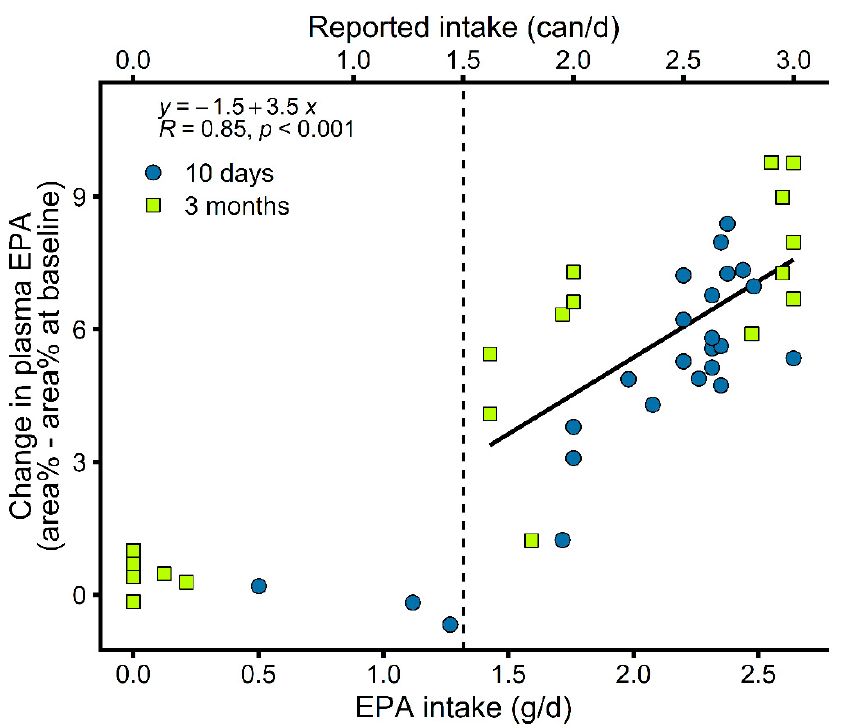
Figure 4. A Plasma EPA dose-response in breast cancer patients supplemented with fish oil was assessed using reported supplement intake. Plasma EPA started increasing at a threshold of approximately 1.3 g of EPA intake per day, corresponding to the intake of 1.5 cans per day of the supplement. We used this reported supplement intake value as a threshold to assess the compliance of both groups (dashed line). EPA, eicosapentaenoic acid (20:5n ‐ 3).